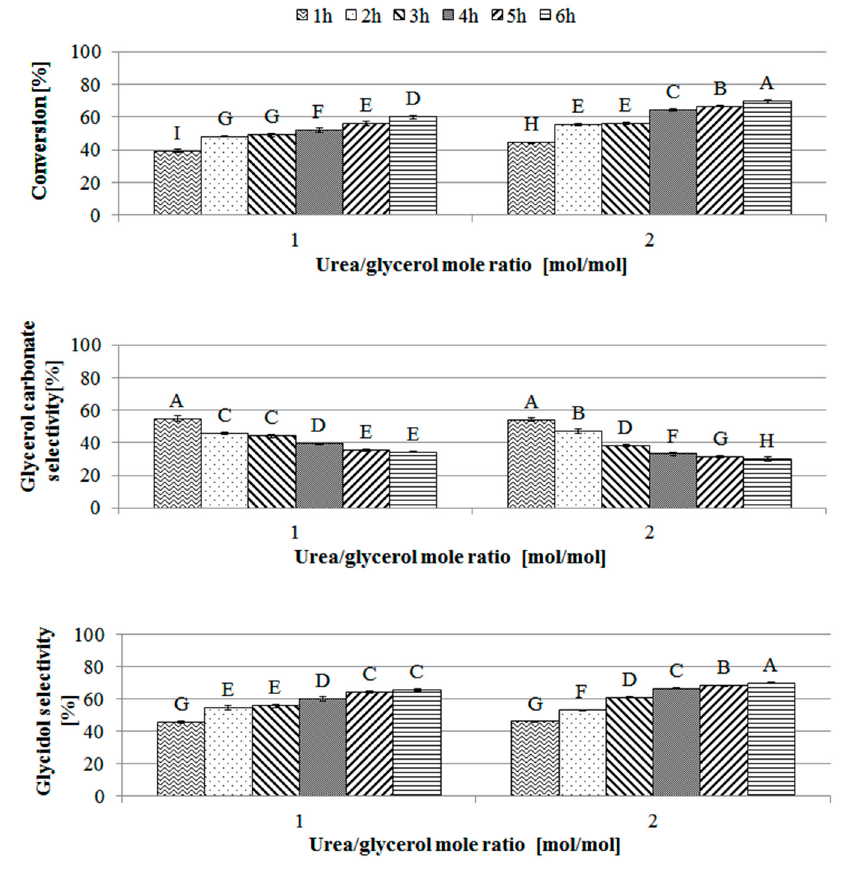
Figure 6. The influence of molar ratio on the catalytic performance of a biosolids-based catalyst. For the reactions shown below, the catalyst:glycerol ratio was maintained at 9 wt % at a reaction temperature of 140 °C and using an air stream. To determine the effect of using different urea:glycerol ratios, two molar ratios were employed: 2:1 and 1:1 (mol/mol). The means of triplicate experiments are reported, with the error bars representing standard deviation. Data annotated with different letters are significantly different (confidence level of 95%).